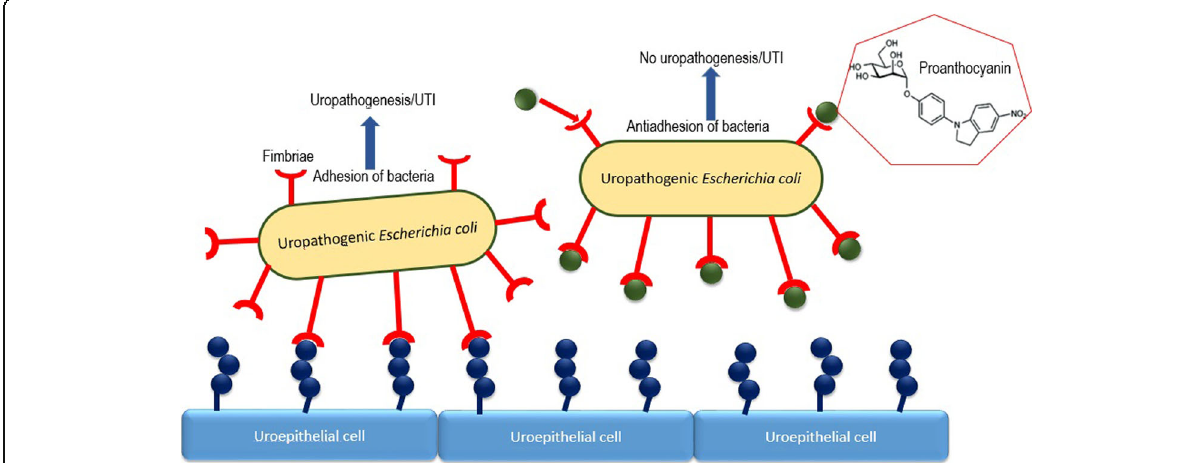
Fig. 1 Type 1 or P-fimbriae inhibitors (e.g., proanthocyanins) are shown as green balls interfering with binding of bacterial fimbriae to uroepithelial